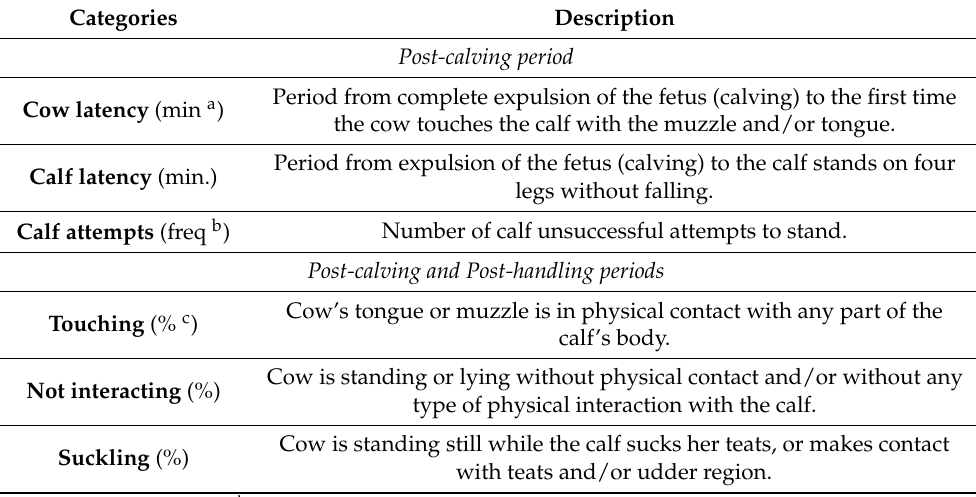
Table 1. Ethogram of primiparous Gyr dairy cow and calf behaviors in Post-calving and Post-handling